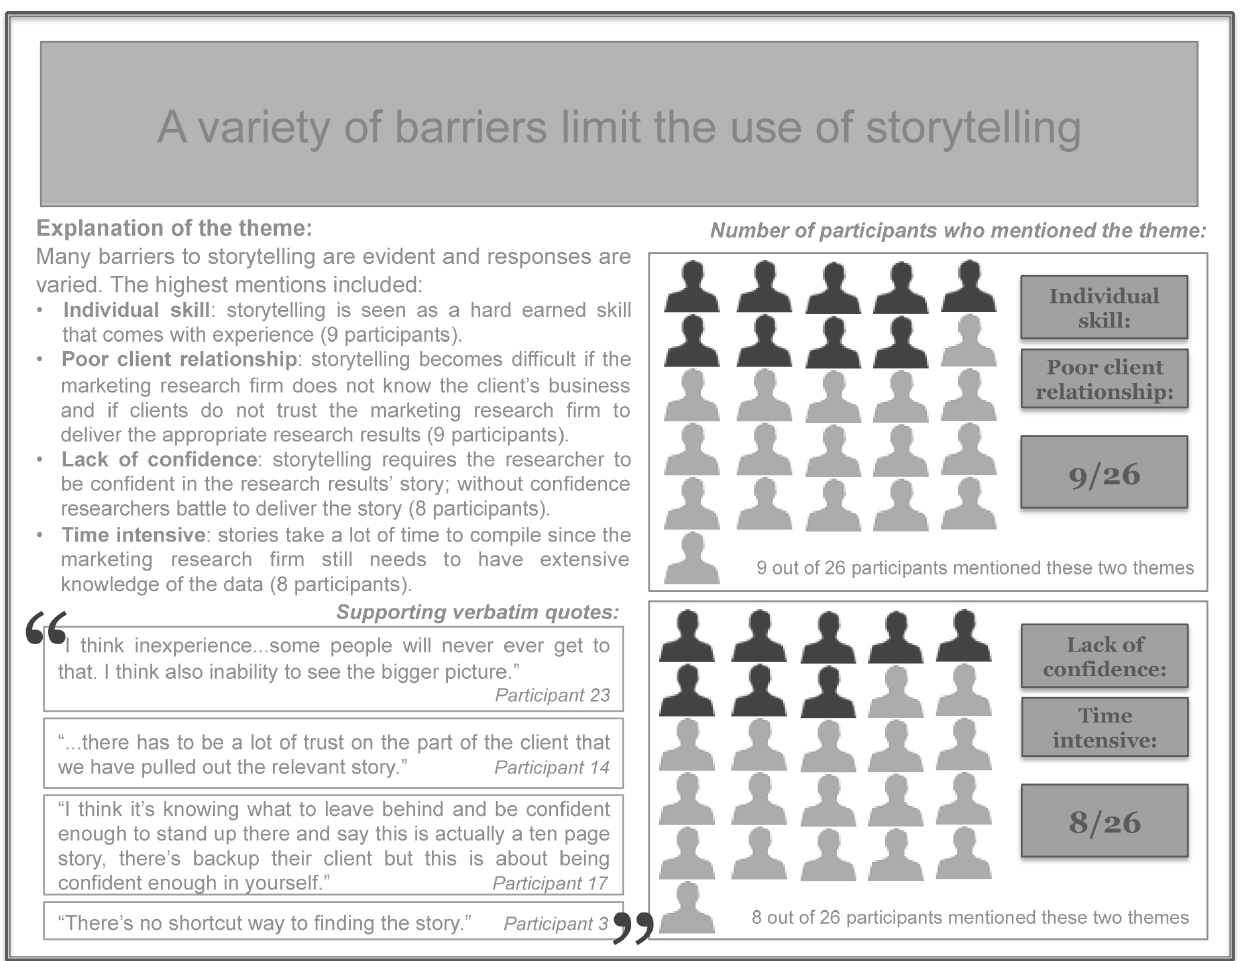
FIGURE 3: Barriers to using